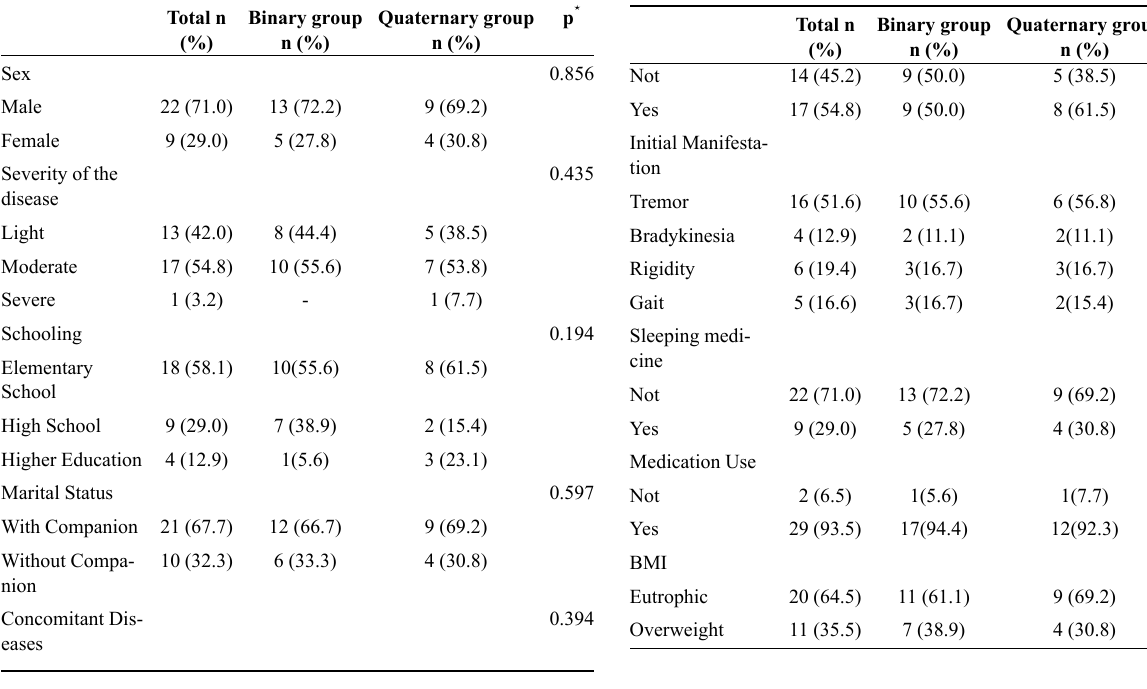
Table 3 - Characteristics of participants according to randomized group (binary and quaternary) (N =